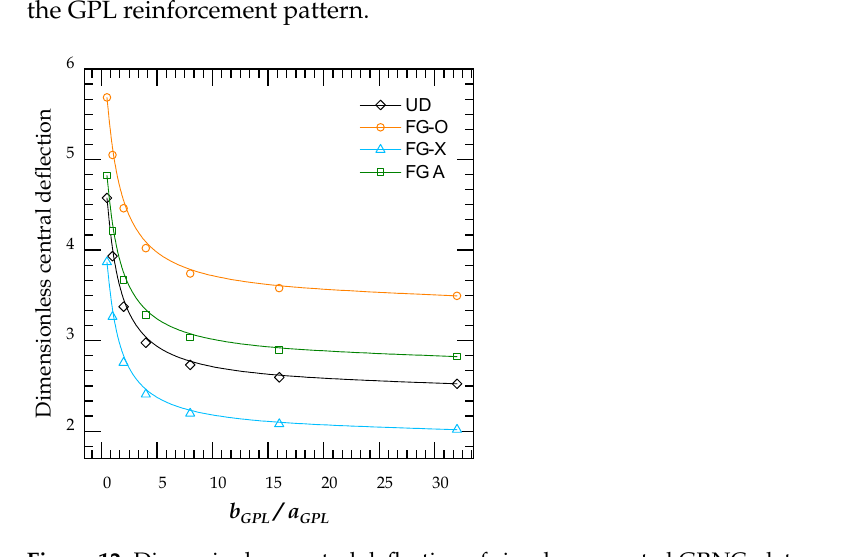
Figure 12. Dimensionless central deflection of simply supported GRNC plate versus the width-to- length ratio of the GPL nanofillers (g (cid:2891)(cid:2900)(cid:2896)∗ = 1%, 𝑎 (cid:2891)(cid:2900)(cid:2896) ℎ (cid:2891)(cid:2900)(cid:2896) ⁄ = 10 (cid:2870) ) . Figure 13 plots the influence of weight fraction g (cid:2891)(cid:2900)(cid:2896)∗ on the transverse displacement of GRNC plates subjected to various boundary conditions. The highest deflections are for SSSS plates and pure Epoxy (g (cid:2891)(cid:2900)(cid:2896)∗ = 0.0%) .